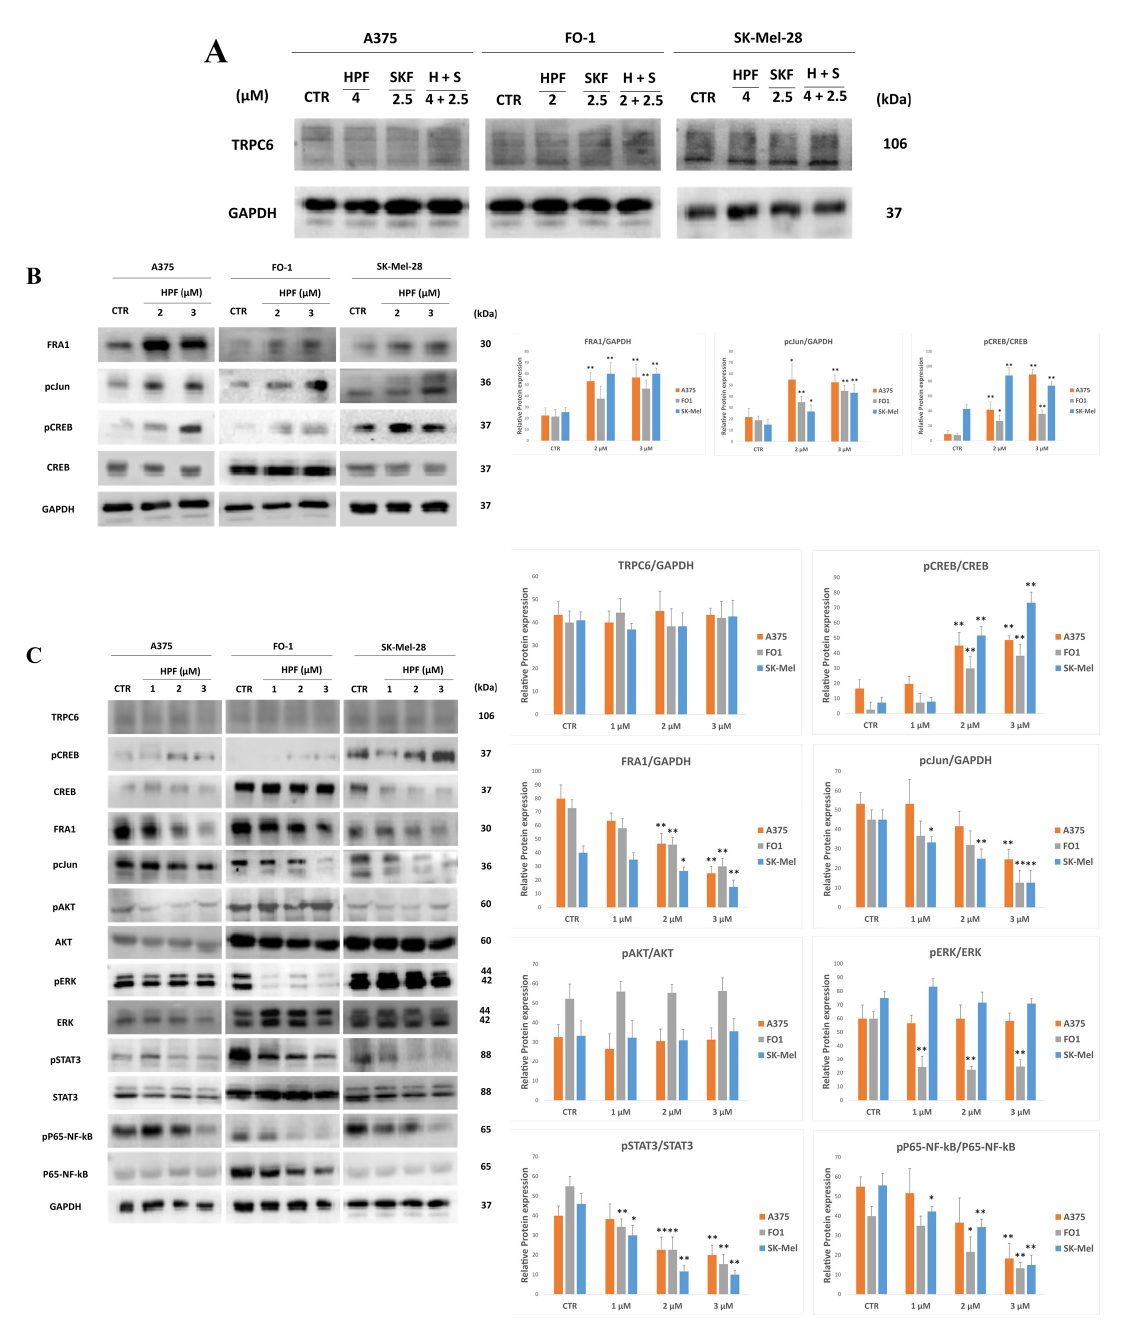
Figure 6. Hyperforin affects the expression levels of key proteins involved in signaling. ( A ) Represents immunoblots showing the expression level of TRPC6 in A375, FO-1 and SK-Mel-28 melanoma cells treated for 2 h with HPF, SKF, or both compounds. ( B ) Represents immunoblots showing the expression level of Fos-related antigen 1 (FRA1), the phosphorylated form of proto-oncogene c-Jun (pcJun) and of cyclic AMP response-element binding protein (pCREB), and total CREB in melanoma cells treated for 2 h with 0, 2 and 3 µ M HPF concentrations. On the right, histograms represent the mean values ± S.D. of protein expression levels measured by densitometry deriving from three independent experiments and normalized with GAPDH expression, unless otherwise stated.